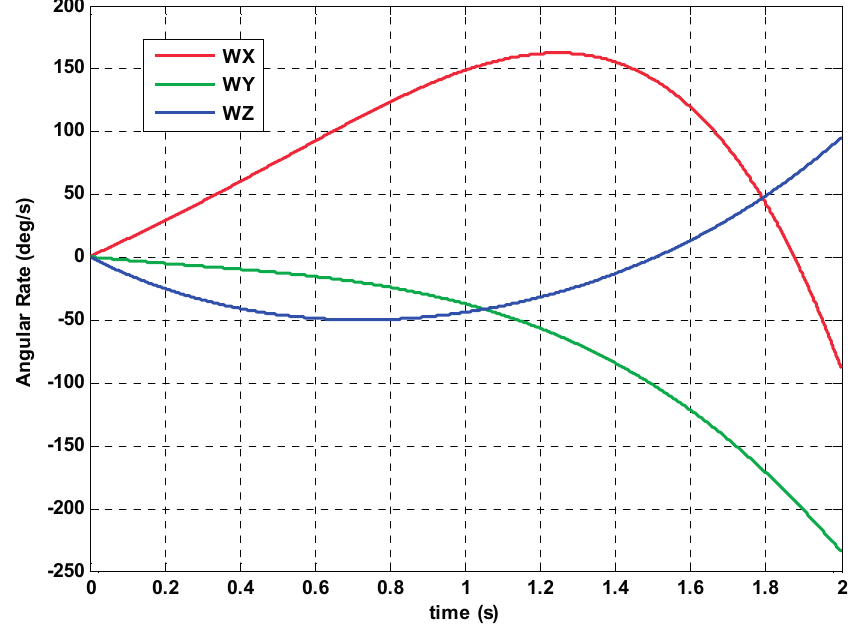
Figure 2. Maneuver angular rate (deg/s) vs . time (s).